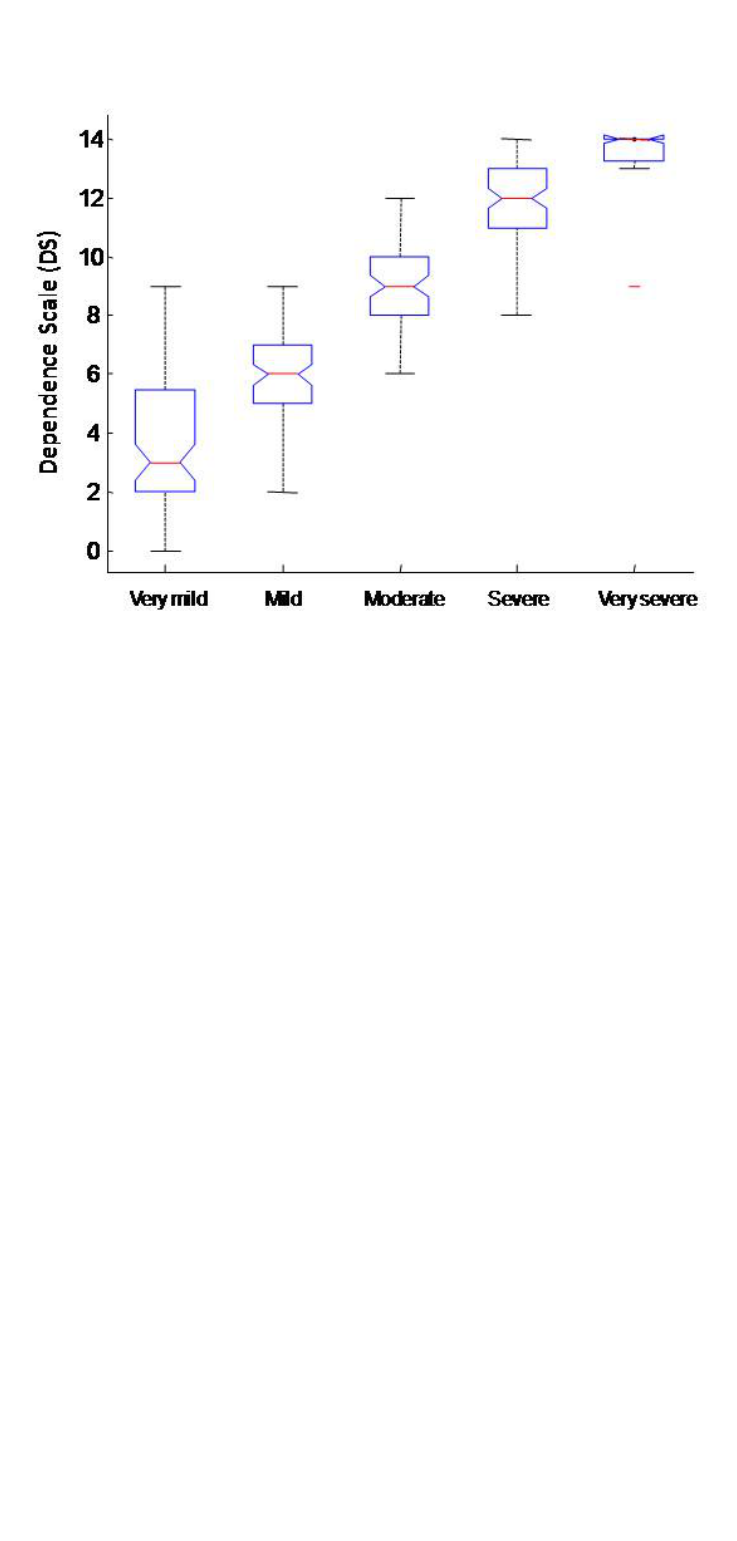
Figure 3. Dependence Scale score by grade of severity as a box-and-whiskers plot. The boxes show medians (red lines), edges at the quartiles Q1 and Q3; the whiskers show the boundary for the